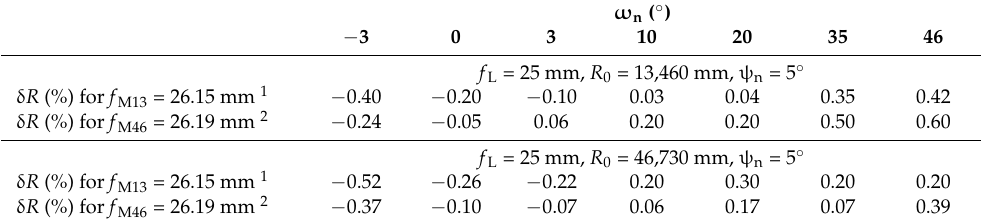
Table 9. Errors for various optimal model focal lengths.